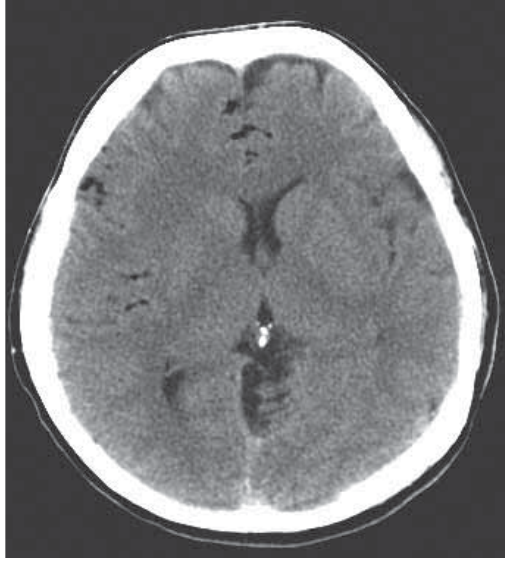
FIGURE 2. Brain CT showing fat droplets within right fi ssure Sylvii and interhemispheric fi ssure.